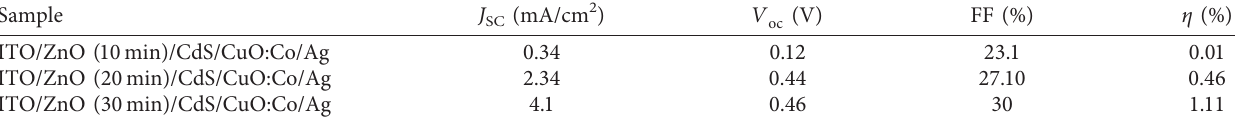
Table 2: Parameters of the ITO/ZnO/CdS/CuO:Co/Ag solar cells at different thicknesses of zinc oxide under